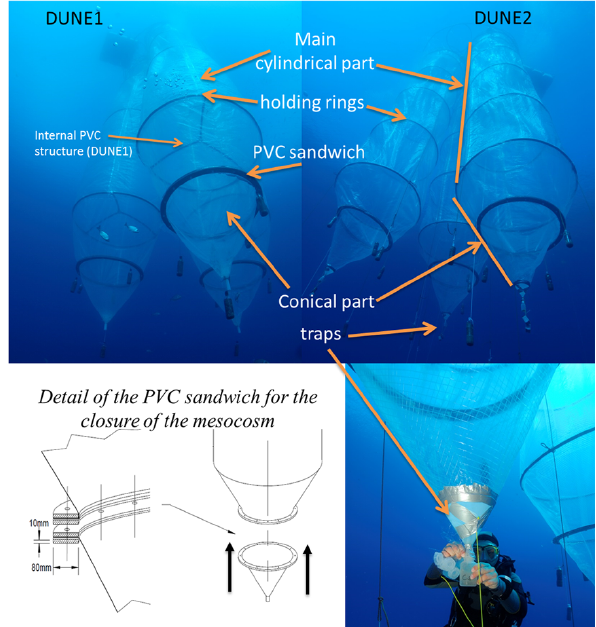
Fig. 4. Pictures of the mesocosms underwater during DUNE-1 and DUNE-2 illustrating the different aspects of the specific mesocosm design developed during DUNE. The cone at the bottom is installed underwater by two divers 24h after the top piece has been deployed from the surface: the two PVC sandwiches are joined with plastic screws (photo: D. Luquet,